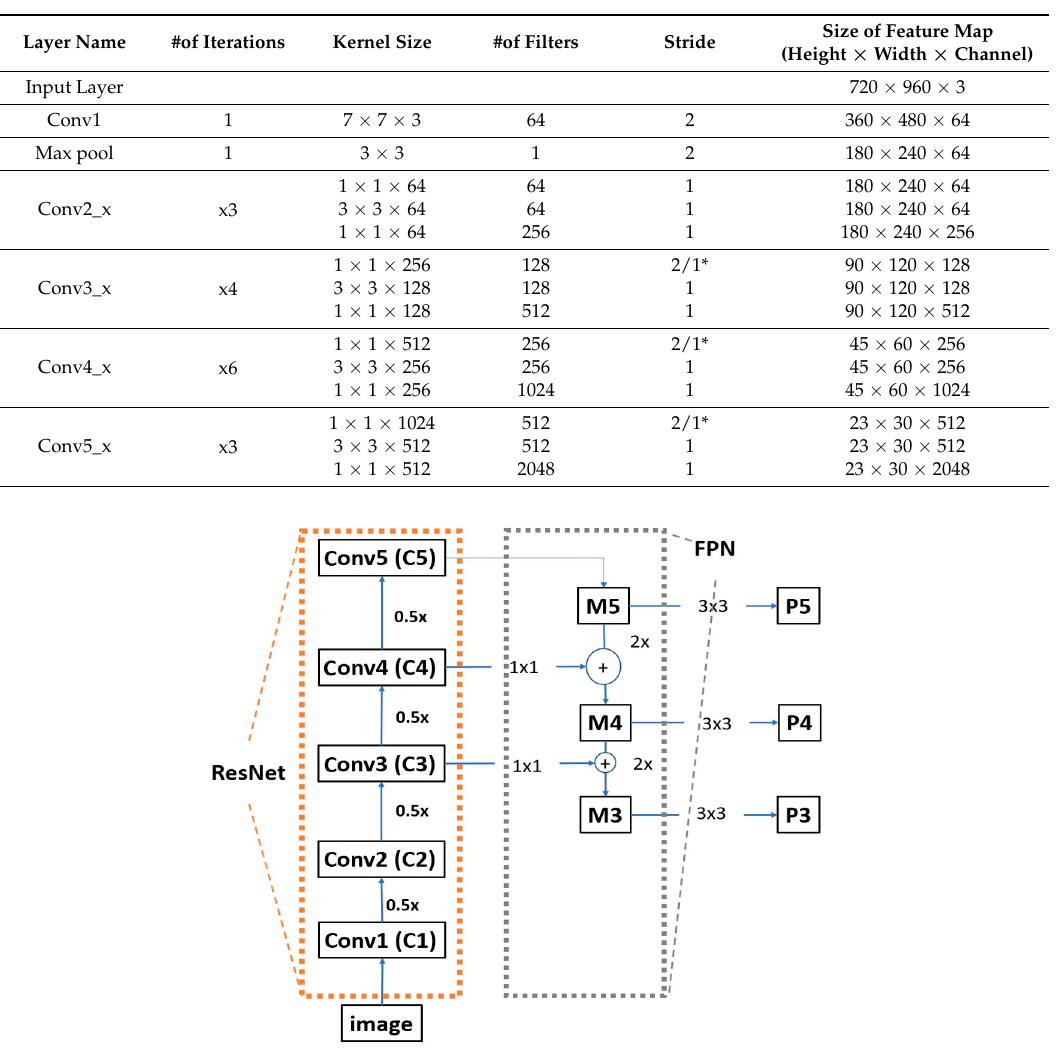
Table 2. Revised ResNet50 architecture used in our RetinaNet. Each layer is followed by batch normalization (BN) and rectified linear unit (ReLU) activation function. 2/1* means 2 at the first iteration and 1 from the second iteration. The shortcut for a 1 × 1 convolutional filter is included in each layer of Conv2_x, . . . , Conv5_x. Conv1 is performed with the feature map including a padding of 3, whereas the convolutional filtering of 3 × 3 × depth in Conv2_x, . . . , Conv5_x is performed with